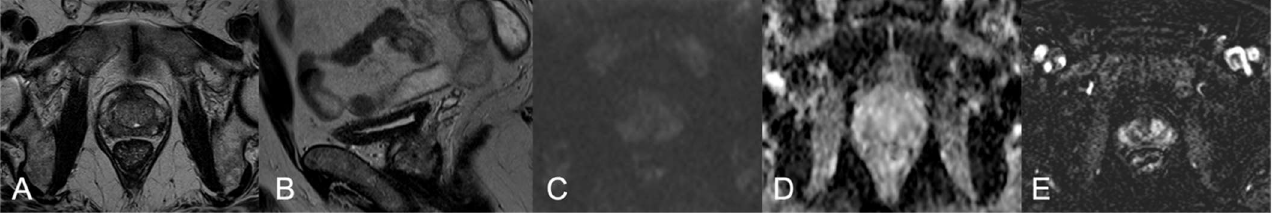
Figure 3. The mpMRI (( A ): axial T2w image; ( B ): sagittal T2w image; ( C ): high b-value DWI; ( D ): ADC map; ( E ): DCE image) performed 1 year later shows the almost complete resolution of the findings mentioned in Figure 2 and in the text (case 3).